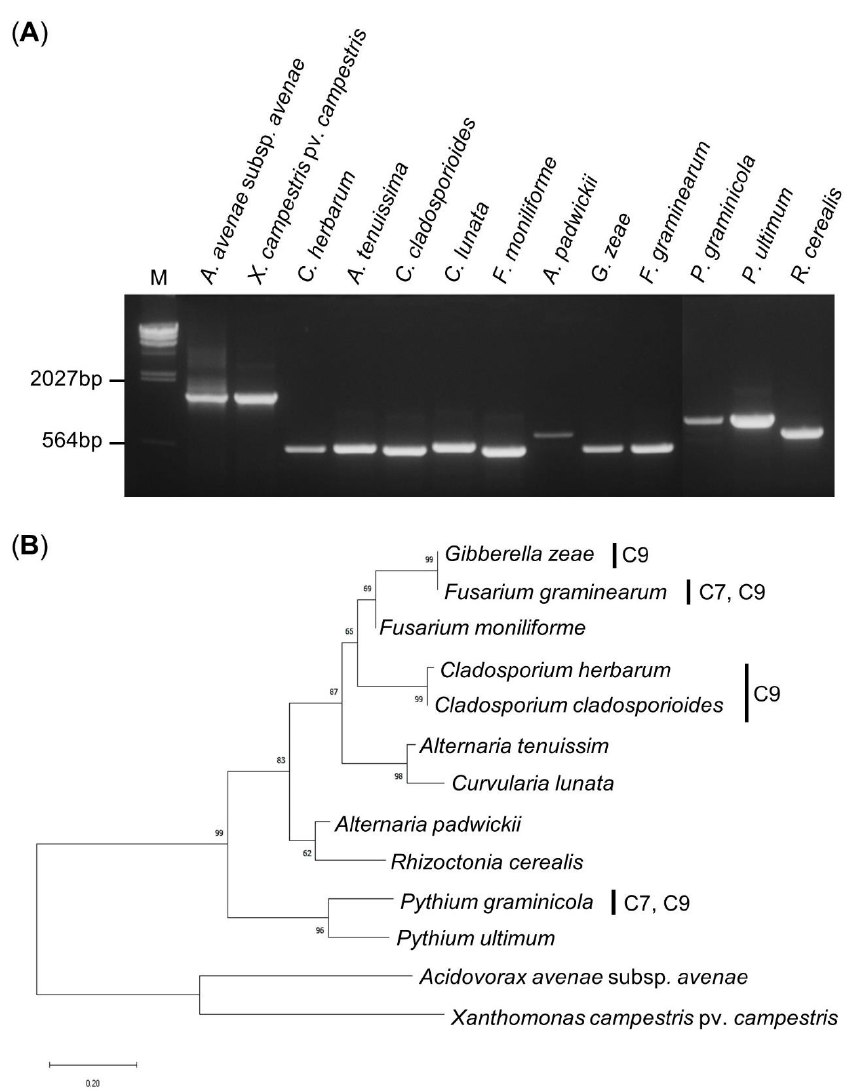
Figure 4. PCR amplification and phylogenetic tree. (A) Gel electrophoresis of the PCR products of the 16S rRNA region and ITS region using a universal primer. The PCR product was run on a 0.8% agarose gel. M: λ/ Hind III DNA ladder. (B) Phylogenetic tree of the bacterial and fungal strains using the neighbor-joining method. The phylogenetic tree is based on the 16S rRNA and ITS gene sequences constructed with 1000 bootstraps in which the percentages over 50 are indicated in each